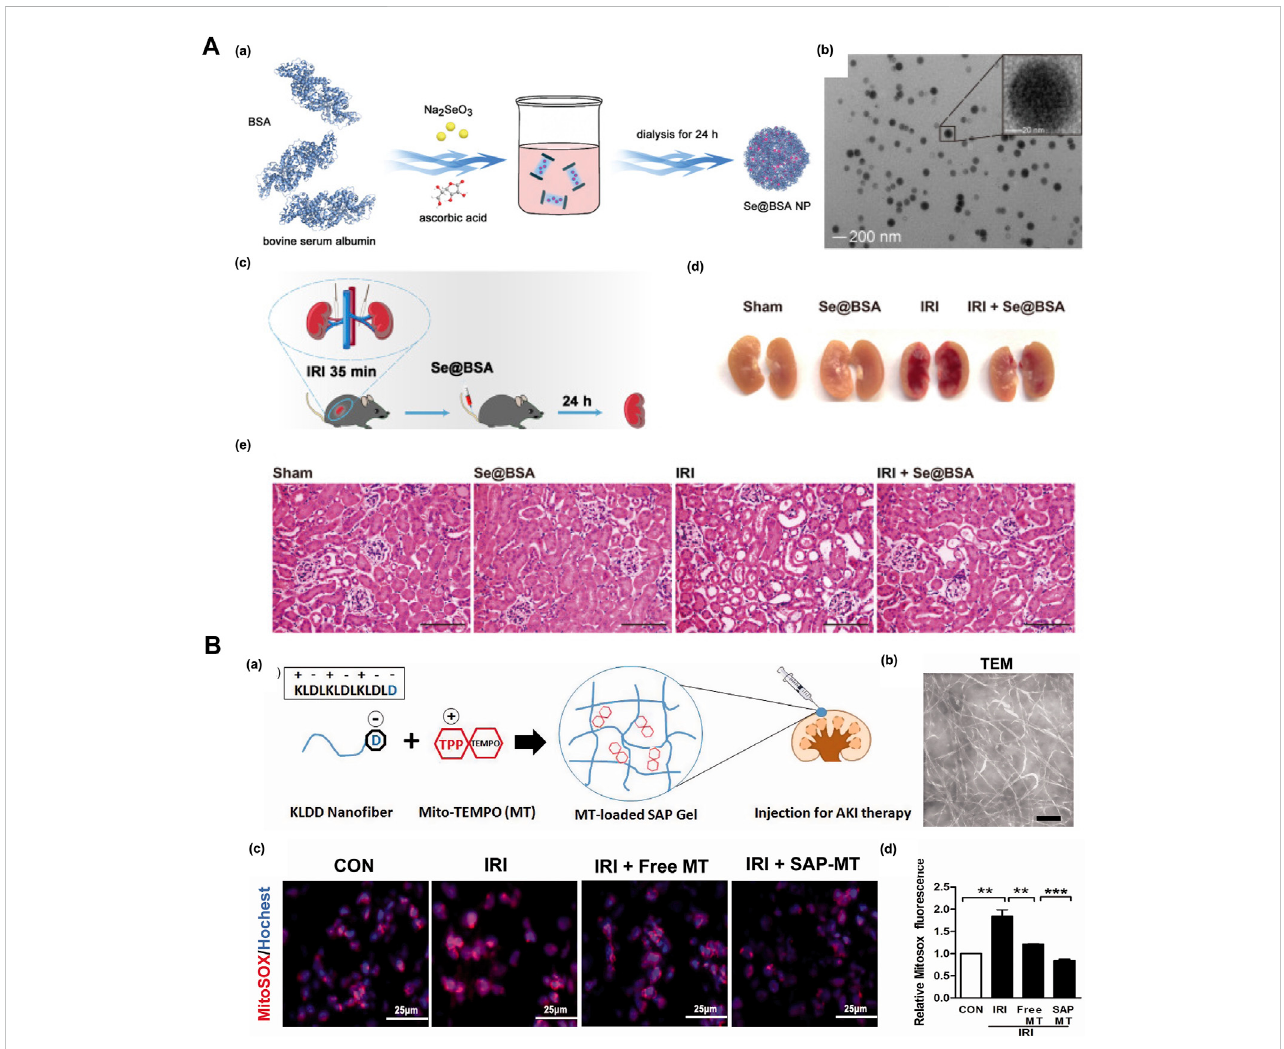
FIGURE 4 (A) (a) The scheme for synthesis of Se@BSA NPs, (b) Se@BSA NPs transmission electron microscope image. The region of interest is enlarged in the illustration,wherethebarescaleindicates20 nm, (c) SchematicdiagramofA)IRI-AKImousemodelestablishment, (d) SeleniumcontentinkidneyofIRI-Akiaki mice.Theresultsareshownasmeanstandarddeviation, (e) HEstainingofthekidneysofAKImicewithSe@BSANPstreatment.Adaptedwithpermissionfrom (Theranostics. 2022, 12 (8), 3882 – 3895) (Wang et al., 2022); (B) (a) Schematic illustration of Mito TEMPO-loaded KLDD peptide hydrogel for AKI treatment, (b) TEM images of KLDD nano fi bers, (c) The production of renal mtROS was detected by MitoSOX staining after frozen sections, (d) Evaluation of renal mtROS level staining. Adapted with permission from (Drug Delivery. 2018, 25 (1), 546 – 554) (Zhao et al.,